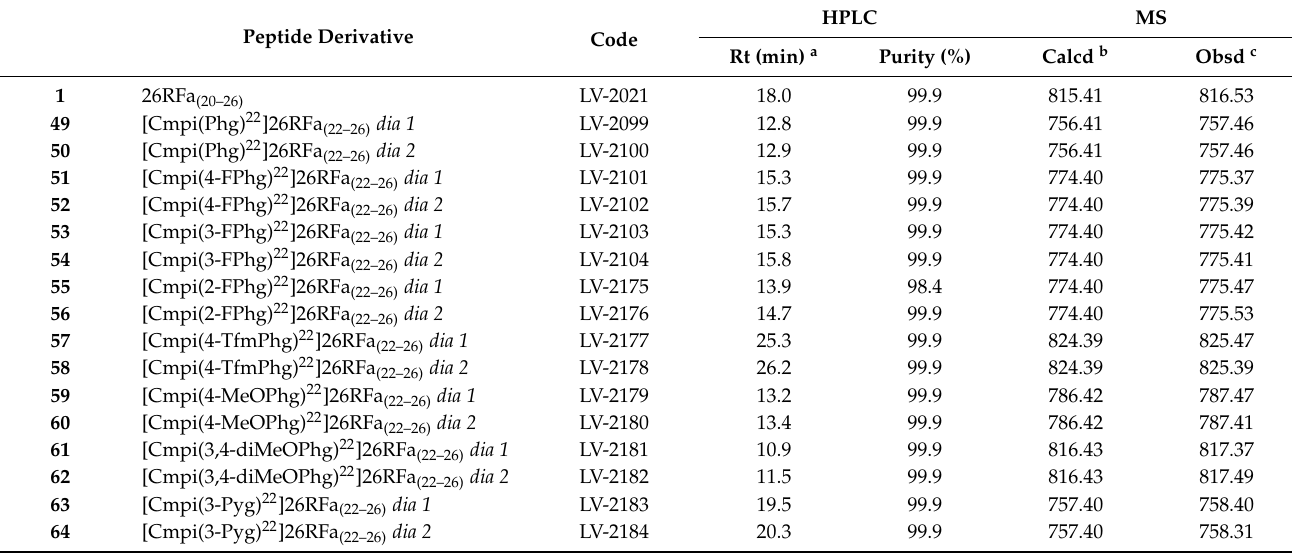
Figure 5. 2-Piperazino-2-aryl-acetic acid derivatives used in place of the H-Gly-Gly-Phe- sequence and incorporated in 49 – 64 . These peptidomimetic moieties were used as racemate. Table 3. Chemical data for 26RFa (22–26)